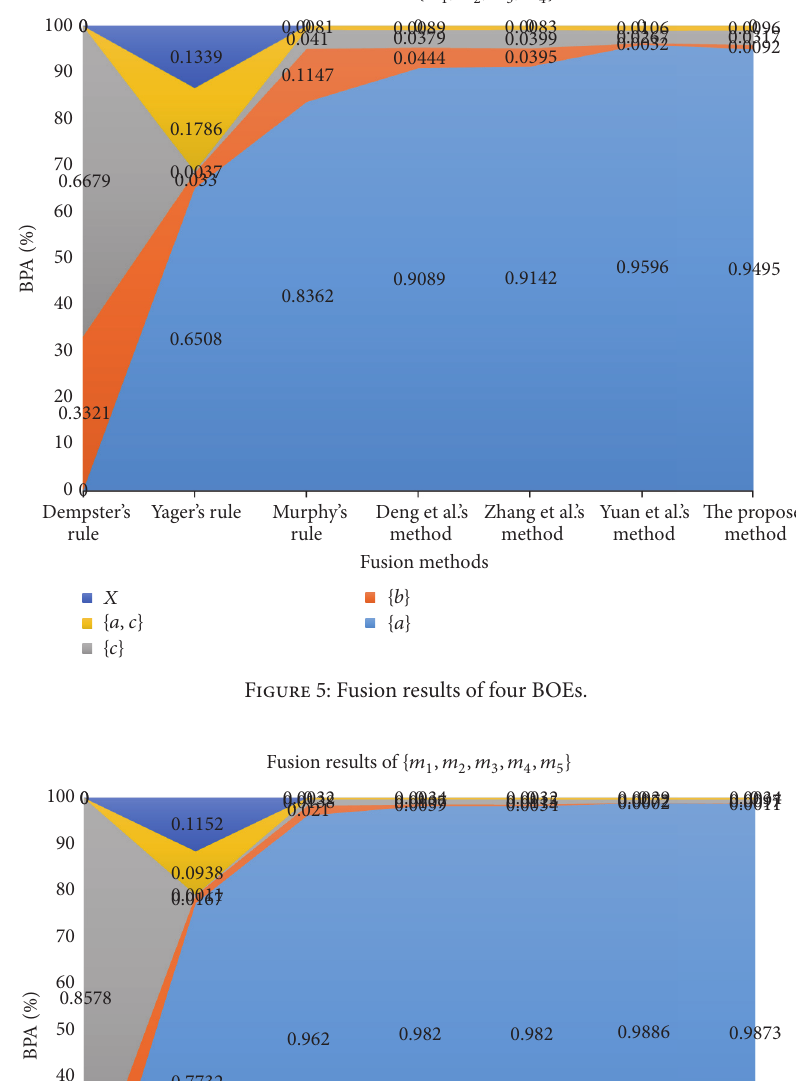
Figure 6: Fusion results of five